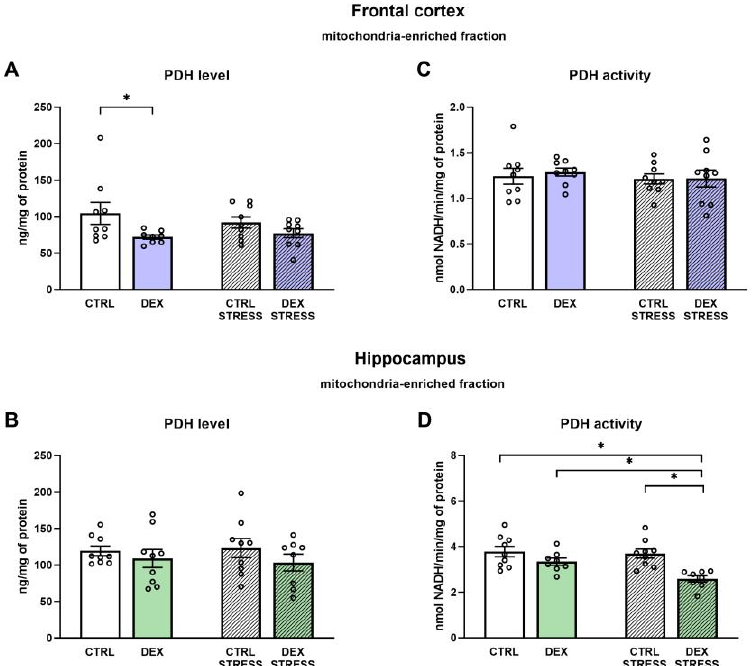
Figure 6. The effects of DEX treatment and acute stress on pyruvate dehydrogenase (PDH) level and activity in the mitochondria-enriched fraction of the frontal cortex ( A , C ) and the hippocampus ( B , D ); PDH level was determined with ELISA assay, while activity with colorimetric assay; * p < 0.05, n = 8–9. The results are expressed as the mean ± SEM. Statistics: two-way ANOVA, followed by the Duncan test.